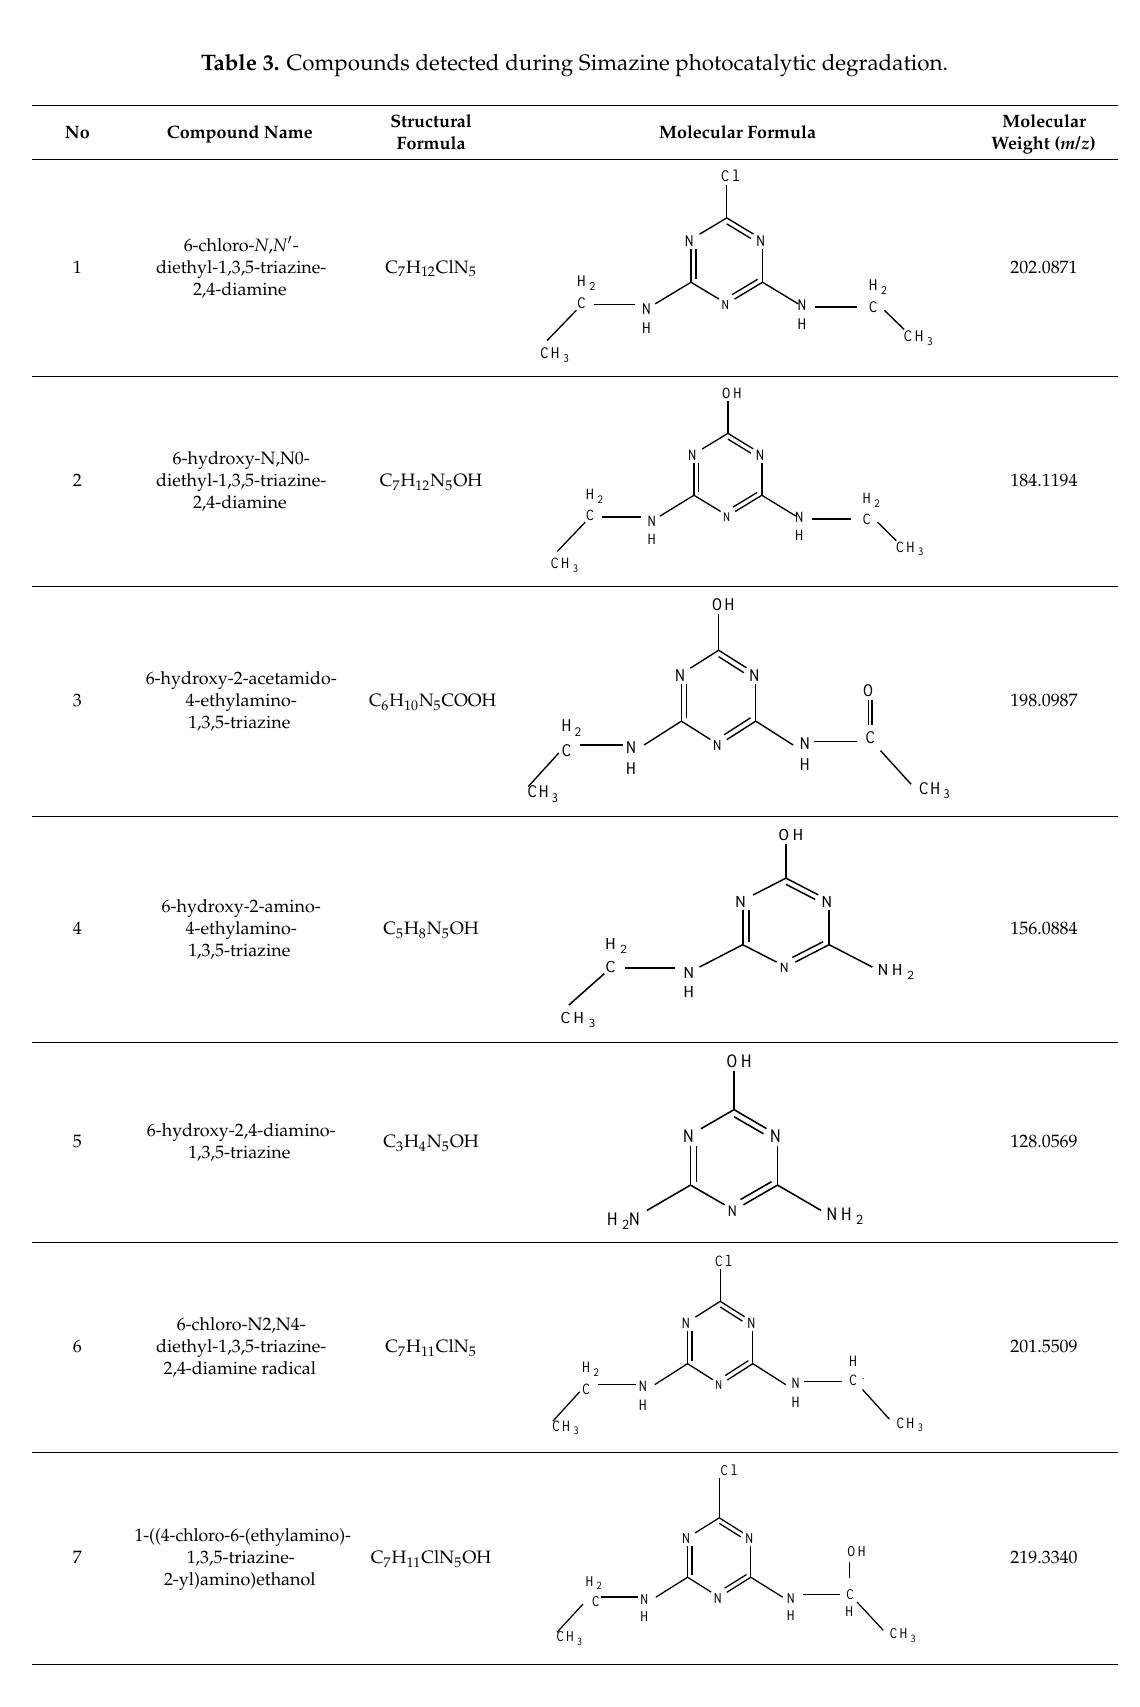
Table 3. Compounds detected during Simazine photocatalytic